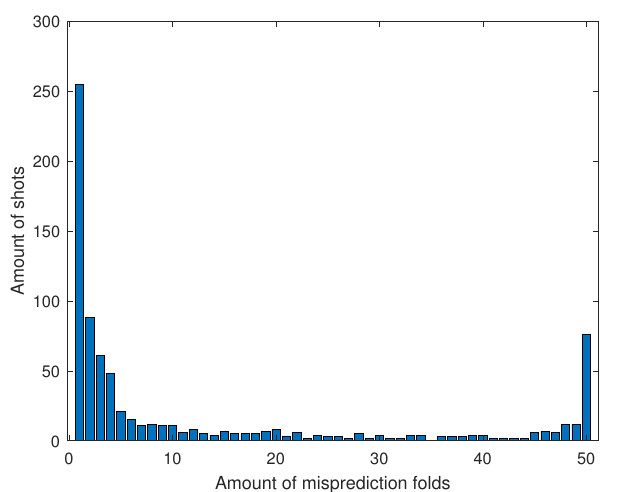
Figure 14. The x -axis gives the amount of folds in which a shot is mispredicted. The y -axis is the amount of shots that occur in the respective bin.